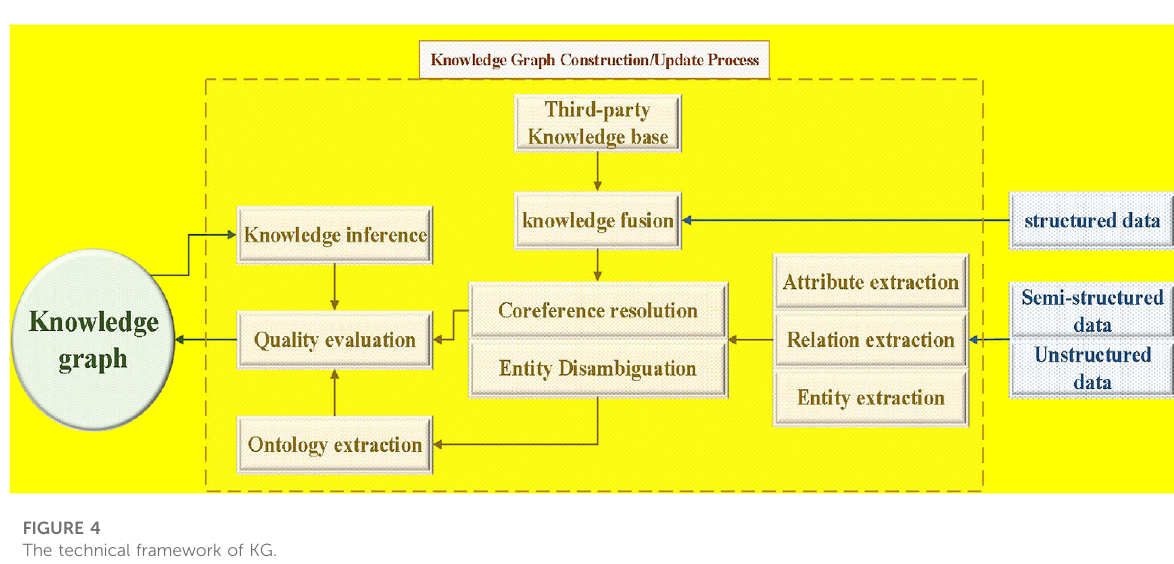
FIGURE 4 The technical framework of